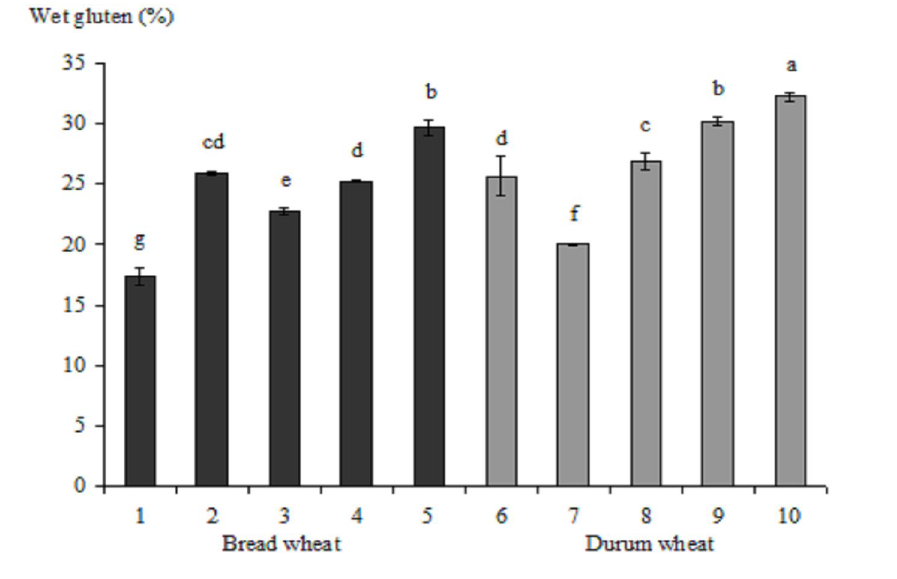
Figure 2. The content of wet gluten in different wheat varieties. 1–5 bread wheat: 1—ZP 87/I, 2—Apache, 3—ZP Zemunska rosa , 4—ZP 224, 5—ZP Zlatna; 6–10 durum wheat: 6—ZP 34/I, 7—10/I, 8—ZP DSP/01, 9—Varano, 10—ZP 7858. Bars with different